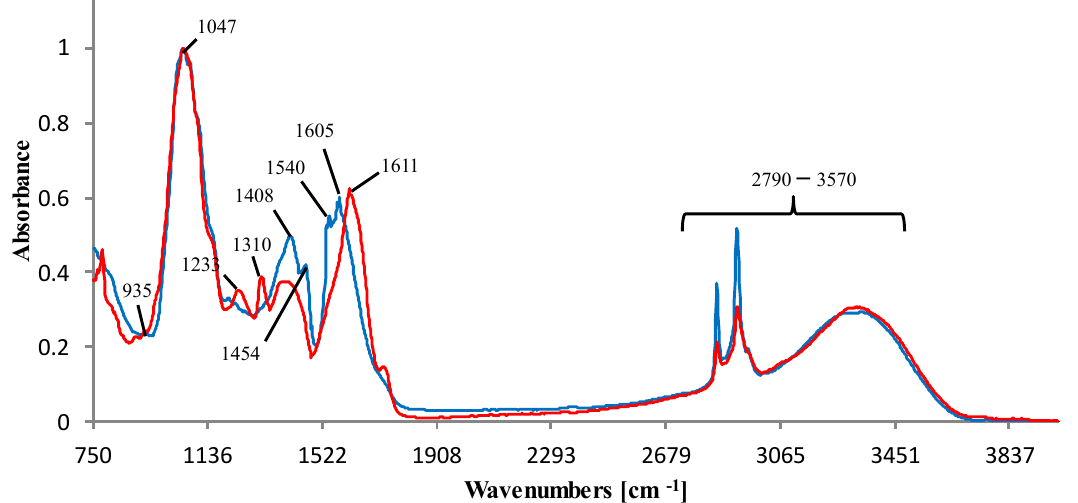
Figure 6. Normalized ATR-FTIR spectra of exemplary samples: white mulberry leaves (blue) and dietary supplement (red).